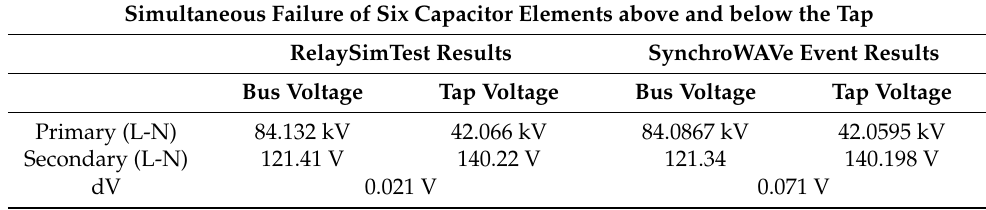
Figure 8. RelaySimTest simulation results for a simultaneous failure of six element failures above and below the tap.